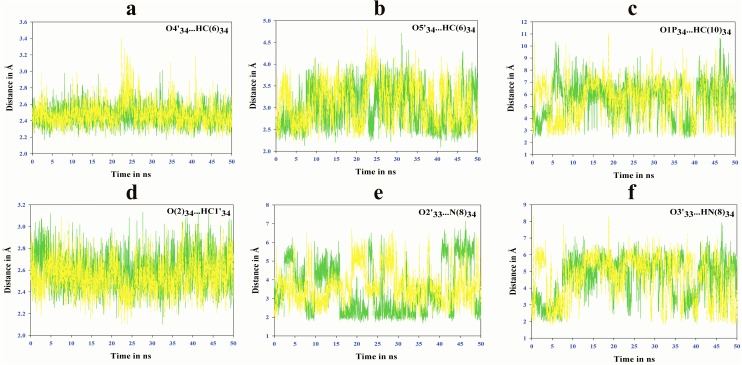
Hydrogen bonding interactions of τm5U.